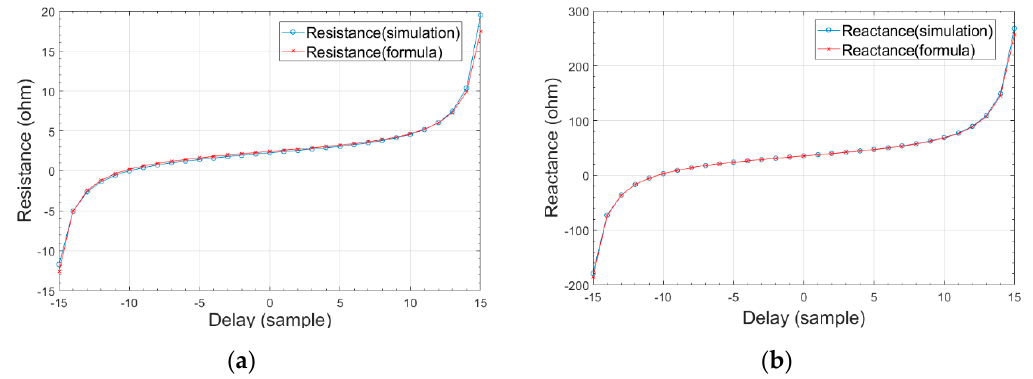
Figure 6. Comparison of distance relay estimated impedance and analytically obtained impedance under AB fault case. ( a ) resistance, ( b ) reactance.